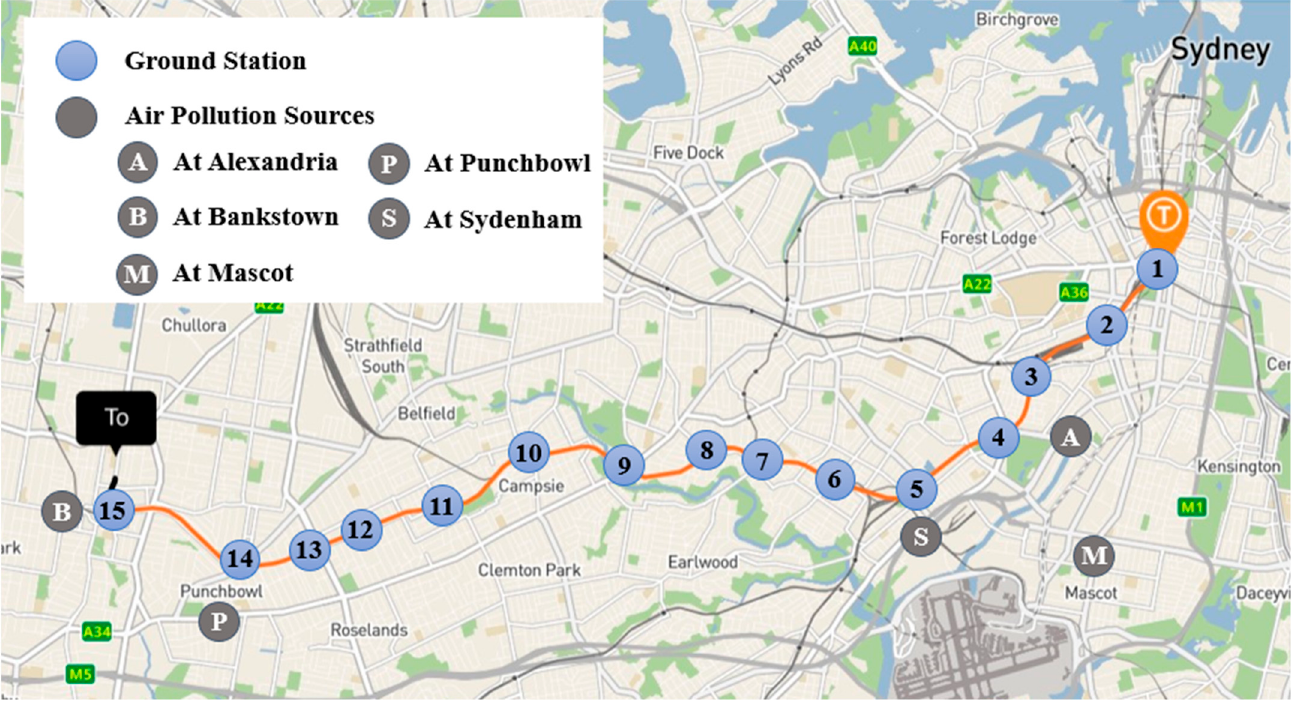
Figure 1. Map of the T3 line from Central Station to Bankstown Station: 1. Central Station, 2. Redfern Station, 3. Erskineville Station, 4. St Peters Station, 5. Sydenham Station, 6. Marrickville Station, 7. Dulwich Hill Station, 8. Hurlstone Park Station, 9. Canterbury Station, 10. Campsie Station, 11. Belmore Station, 12. Lakemba Station, 13. Wiley Park Station, 14. Punchbowl Station, and 15. Bankstown Station.